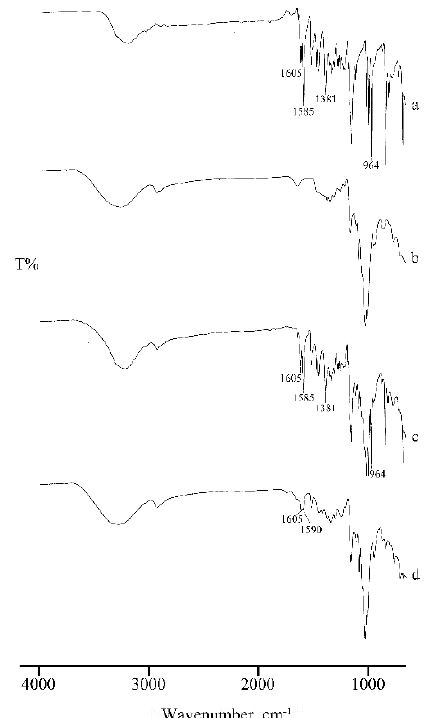
Figure 9. FT-IR spectra of RSV ( a ), γ-CD ( b ), their PM ( c ), and KN product ( d ).